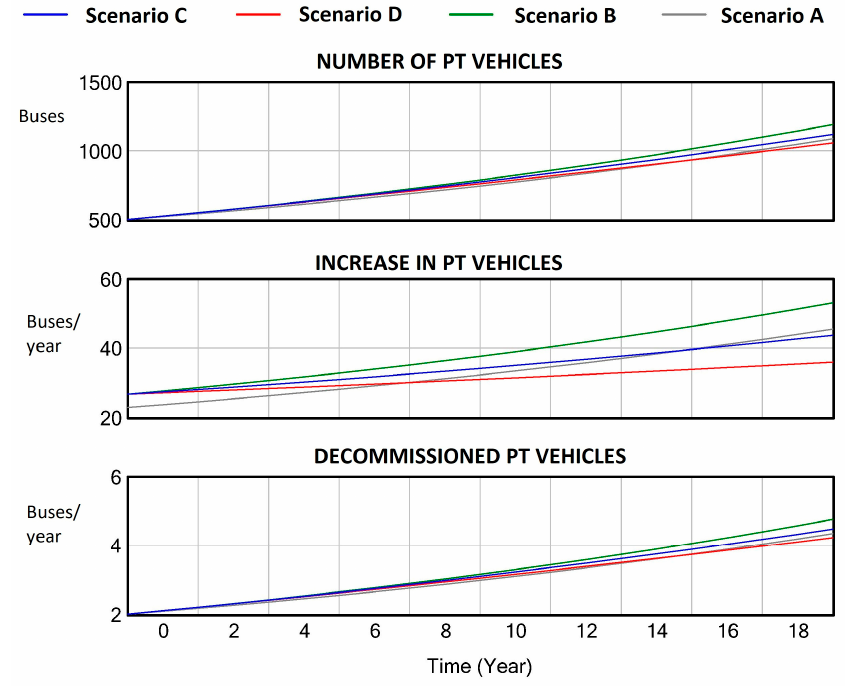
Figure 10. Trend of selected submodel values ‘number of PT vehicles’.